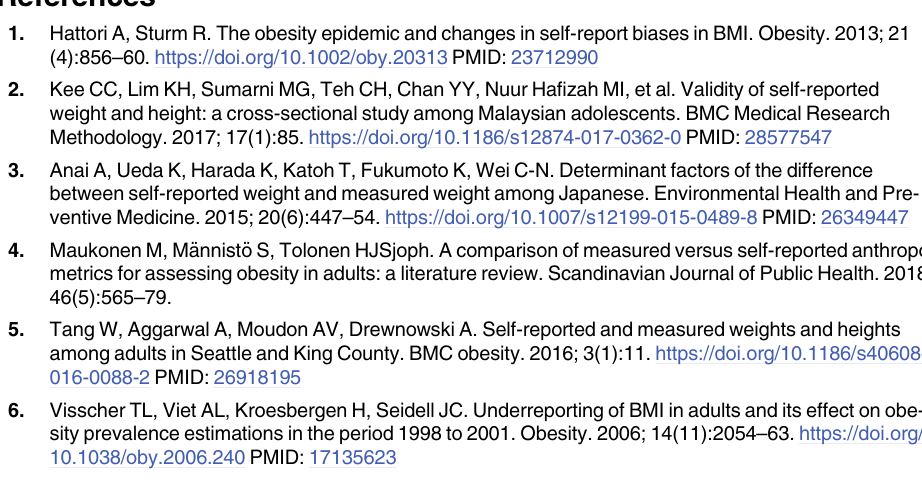
S1 Dataset. Data set of all participants (N = 2781) with socio demographics, measured and self-reported height and